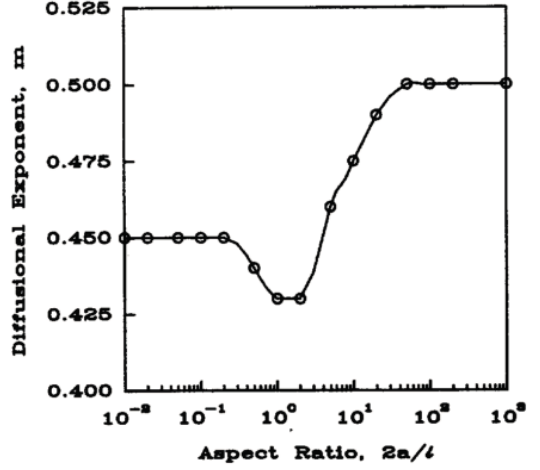
Figure A2. Predicted diffusion exponent as a function of aspect ratio for cylinders. Where a is radius and l is cylinder thickness. Reprinted with permission from